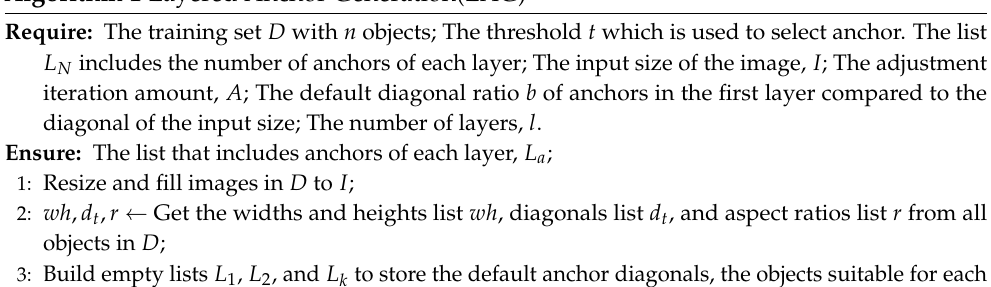
Algorithm 1 Layered Anchor